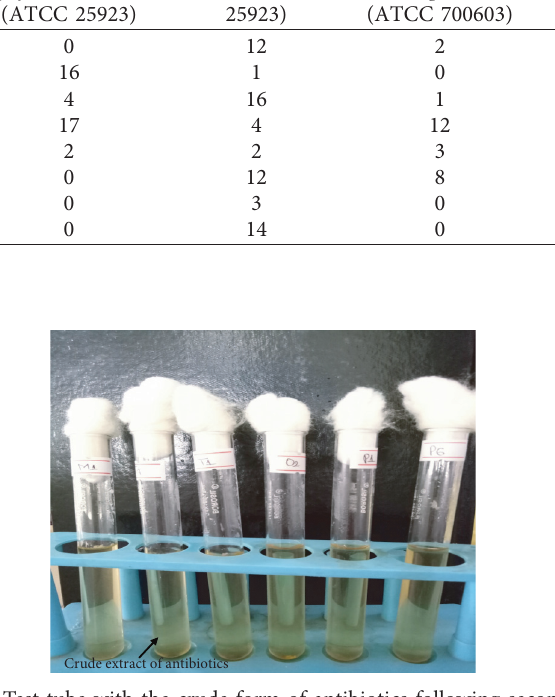
Table 3: Primary screening of the different isolates with effective results. Isolates